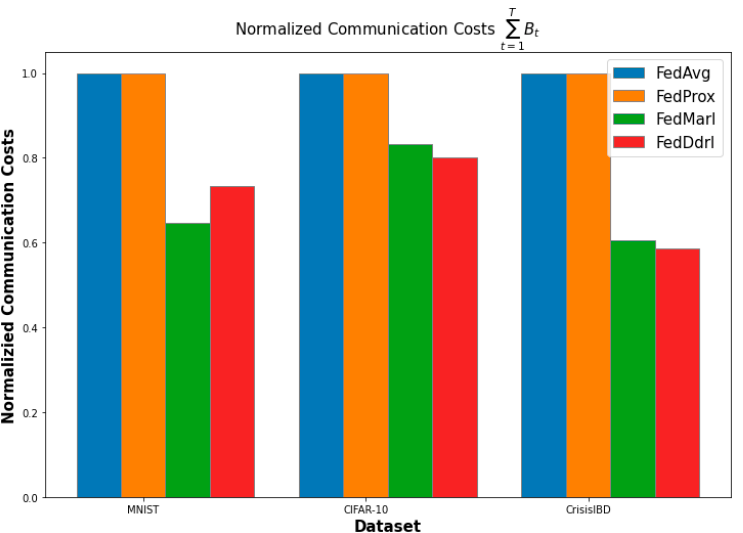
Figure 9. Normalized communication cost of each FL algorithm.